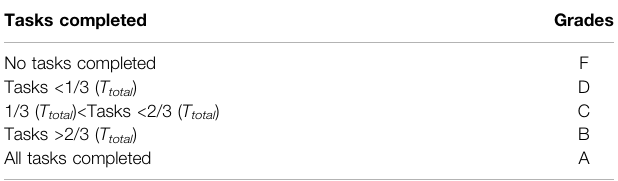
TABLE 2 | Grading system for the grippers based on successful task completion in a given task category. Tasks